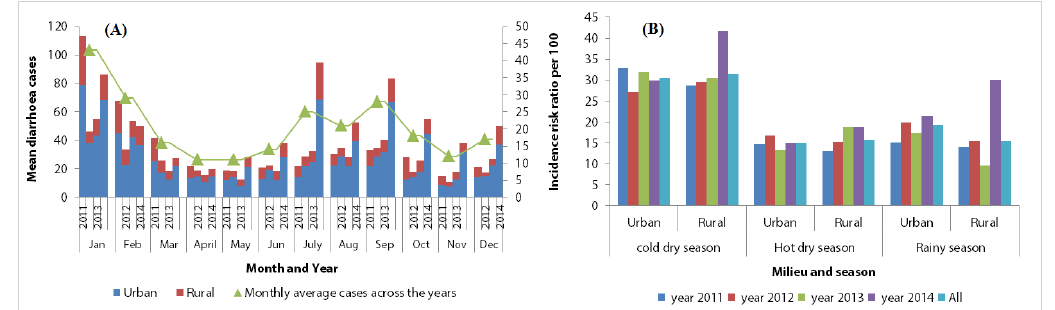
Figure 3. Distribution of mean monthly count of diarrhoeal cases per health facility in urban and rural settings in the health district of Mbour, Senegal over a four-year study period from 2011 to 2014. ( A ) Distribution of mean monthly diarrhoeal cases per health facility, by year, over the study period 2011–2014. ( B ) Distribution of diarrhoeal incidence (number of cases/population at risk times 100) across health facilities in urban and rural settings, and combined in Mbour over the three seasons.